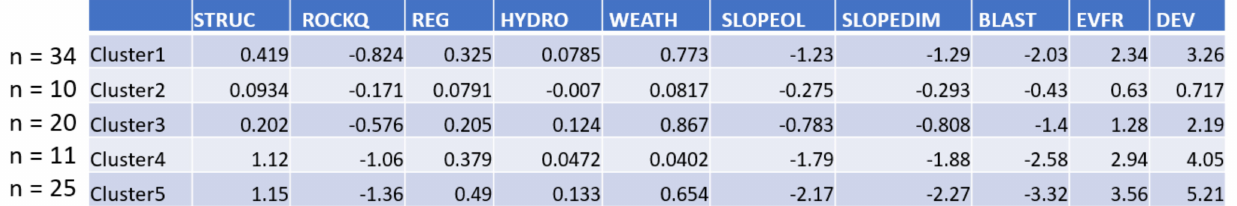
Figure 12. Centroid values. The SOM program provides a ‘centroid value’ for each cluster or set of data. Each sample is then assigned a cluster, whose centroid is most similar to its own values.